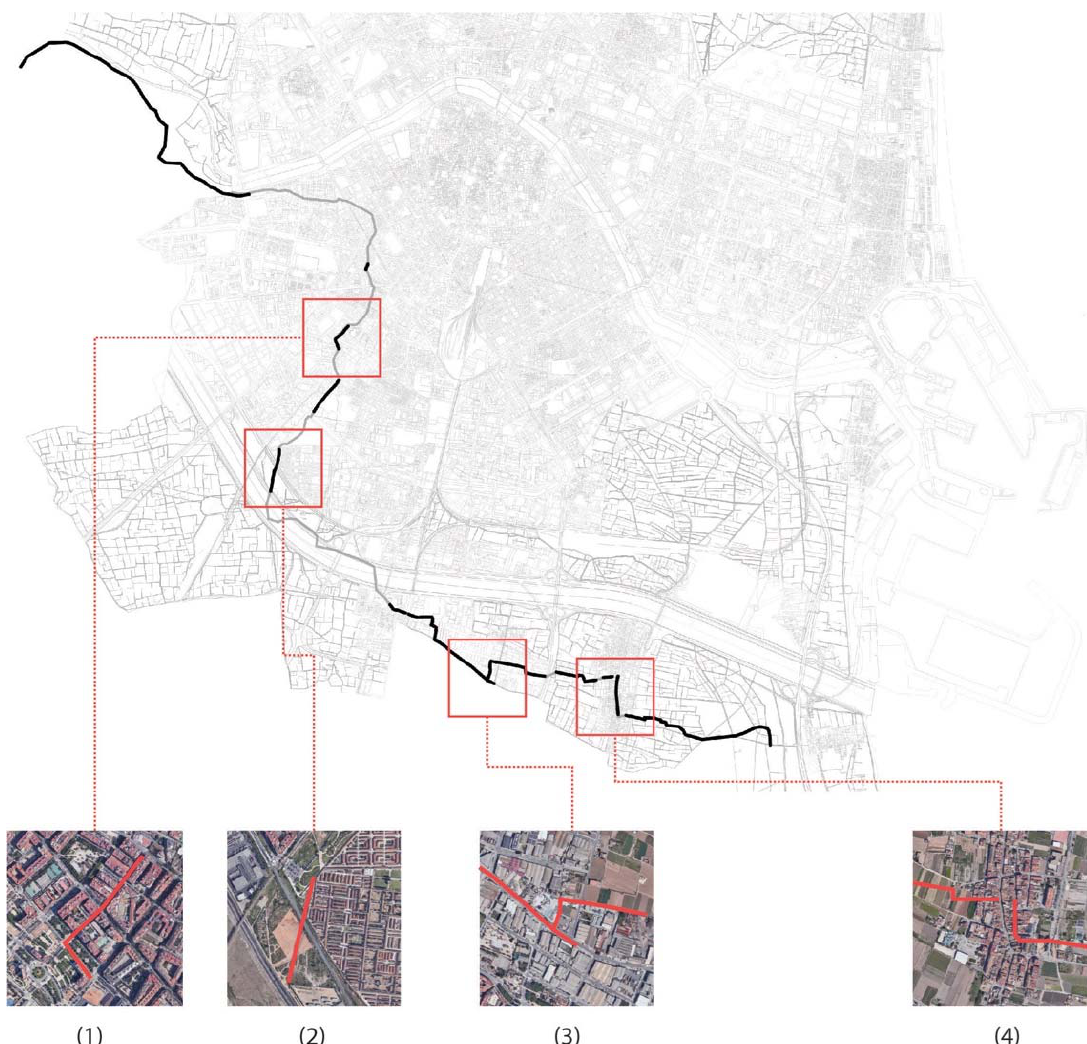
Figure 18. The inheritance of the layout of irrigation canals in urban spatial structure and satellite images showing the type of land configuration in relationship with canal layout. (1) The inheritance located between building block and urban green. (2) The inheritance located in the historic district and newly build riverbed. (3) The inheritance located in the industrial area. (4) The inheritance located in the historical settlement.